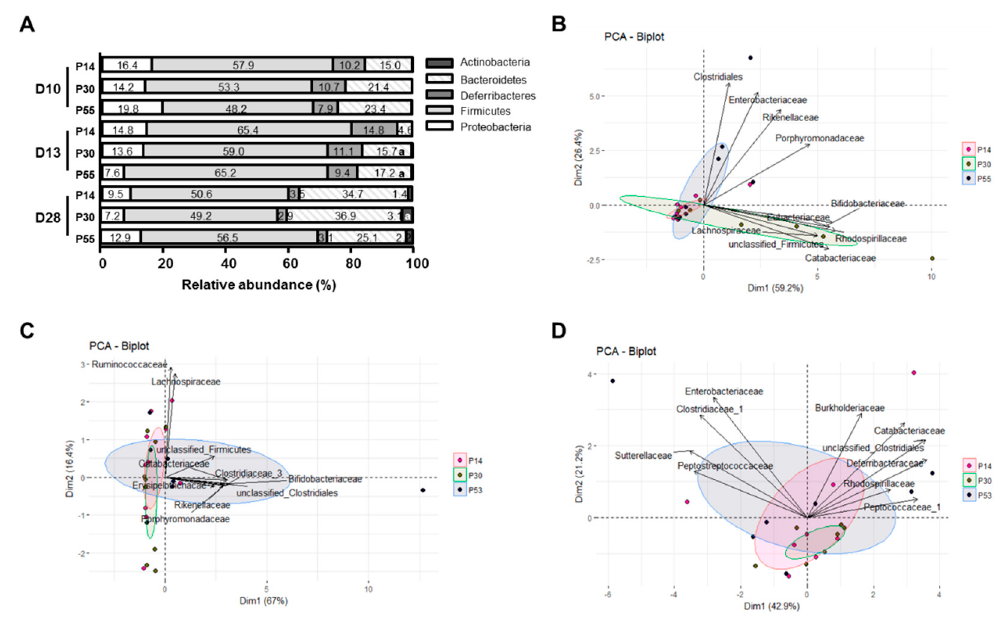
Figure 5. Effects of dietary protein intake on mucosa-associated microbiota composition after 3 (D10), 6 (D13) or 21 days (D28) of dietary intervention with P14, P30 or P53 diet. ( A ). Relative abundance percentages of bacterial phyla in mucosa-adherent microbiota a: vs P14, p < 0.05 at the same time. Due to low relative proportions, Tenericutes is not visible in the figure. ( B – D ): Principal coordinate analysis on family relative abundances of mucosa-adherent microbiota at day 10 ( B ), day 13 ( C ) and day 28 (D).